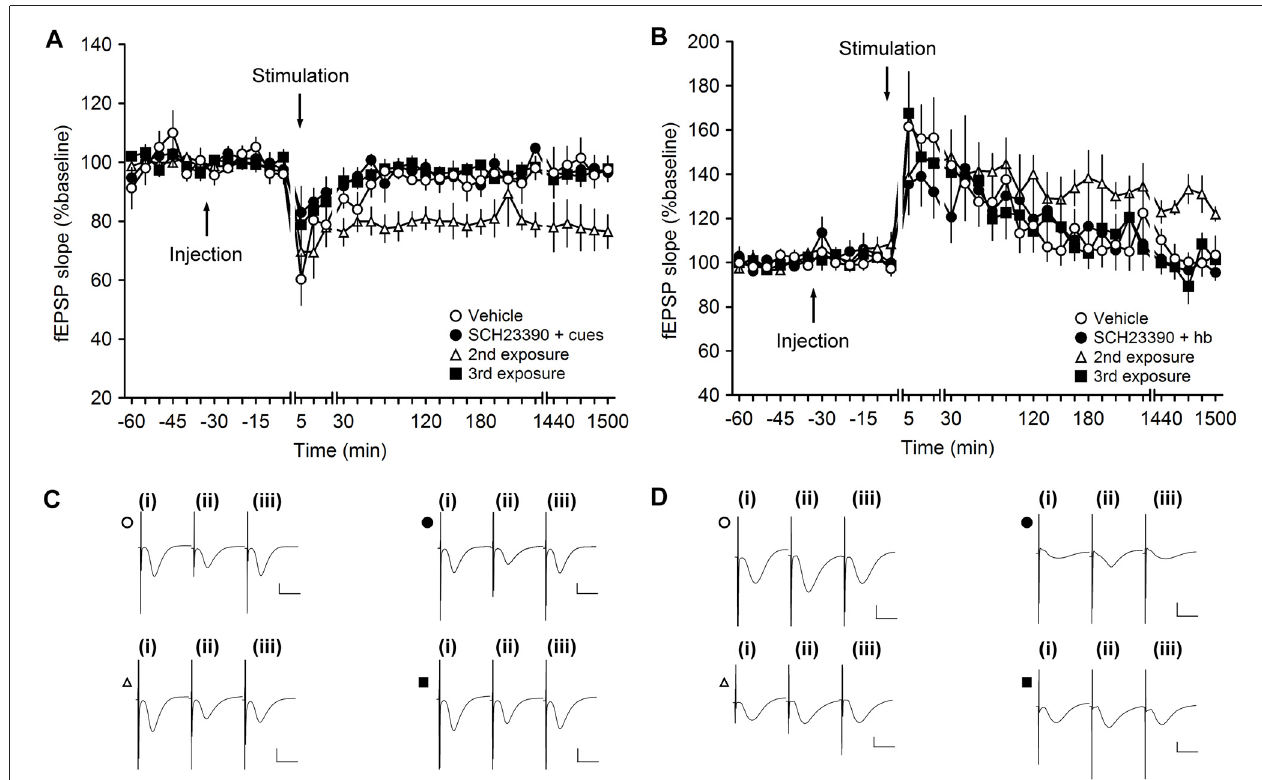
FIGURE 4 | Antagonism of D1/D5 receptors inhibits learning-facilitated plasticity at MF-CA3 synapses. (A) Weak low-frequency stimulation (wLFS; 1 Hz, 600 pulses) results in short-term depression (STD) in vehicle-treated animals. Upon first exposure to landmark cues, application of wLFS also resulted in STD in animals that were treated with SCH23390 (30 µ g). A second exposure (re-exposure) to the same object-place constellations 1 week later resulted in LTD. When the animals explored the cues for a third time (a further week later), wLFS failed to result in LTD. (B) Weak high-frequency stimulation (wHFS, two trains of 100 pulses given at 100 Hz) results in STP in vehicle-treated animals. The first (novel) exposure of the animals to an empty holeboard results in short-term potentiation (STP) in animals that received SCH23390 (30 µ g). A second exposure to the same holeboard 1 week later, leads to a facilitation of LTP that lasts for over 24 h. wHFS given during a third exposure to the same holeboard results in STP. Line breaks indicate change in time scale. (C) Analogs represent fEPSP responses obtained in an LTD experiment where a vehicle-treated animal received wLFS only (open circle), and Schaffer collateral (SCH)-treated animal explored the novel cues for the first time (filled circle), an animal that we exposed to the cues for a 2nd time (open triangle) or a 3rd time (filled square). The following time-points are shown: (i) pre-wLFS; (ii) post-wLFS; and (iii) 24 h post-wLFS. (D) Analogs represent fEPSP responses obtained in an LTP experiment where a vehicle-treated animal received wHFS only (open circle), and SCH-treated animal explored the novel cues for the first time (filled circle), an animal that we exposed to the cues for a 2nd time (open triangle) or a 3rd time (filled square). The following time-points are shown: (i) pre-wHFS; (ii) post-wHFS; and (iii) 24 h post-wHFS. Vertical scale bar: 1 mV, horizontal scale bar: 10